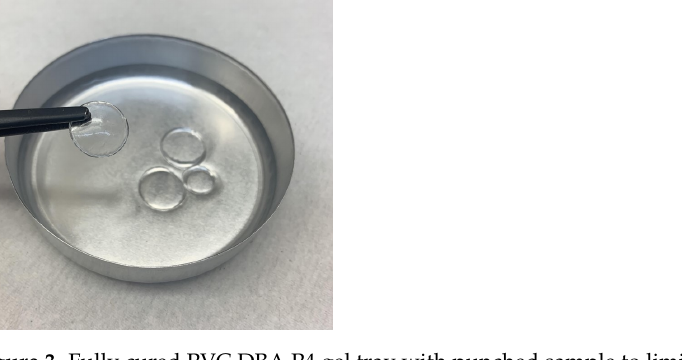
Figure 3. Fully cured PVC DBA P4 gel tray with punched sample to limit irregularities such as edge effects during the curing process.